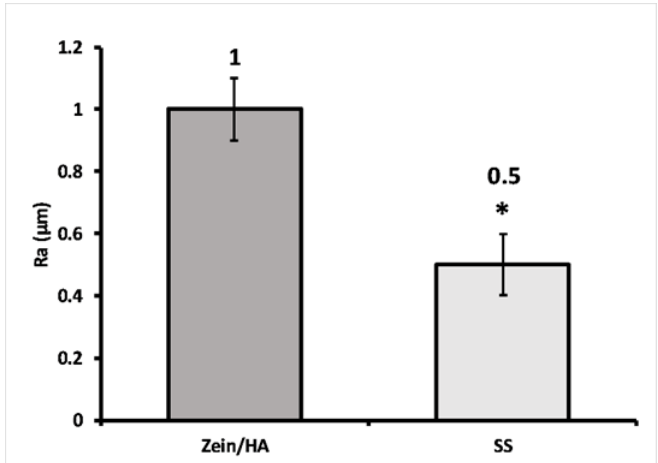
Figure 4. Ra value comparison of zein/HA coating and bare SS with a mean ± standard deviation for five samples of each system (* marks the statistically significant difference p < 0.05).